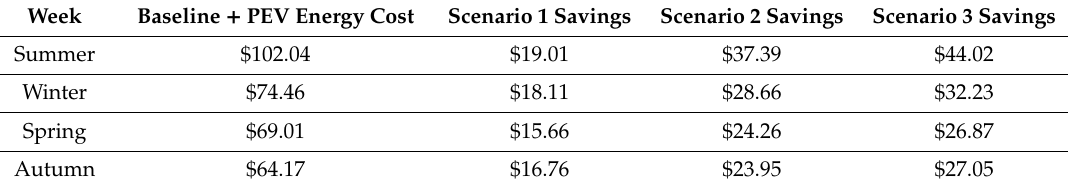
Table 6. Di ff erent scenarios weekly savings summary